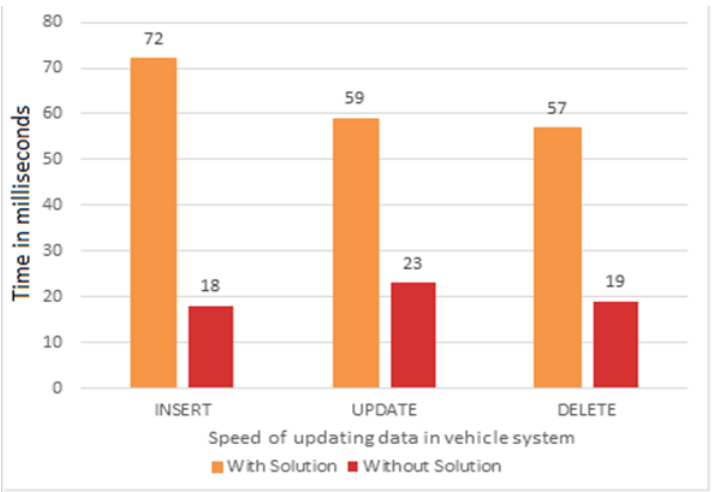
Figure 11. Execution speed of records update.